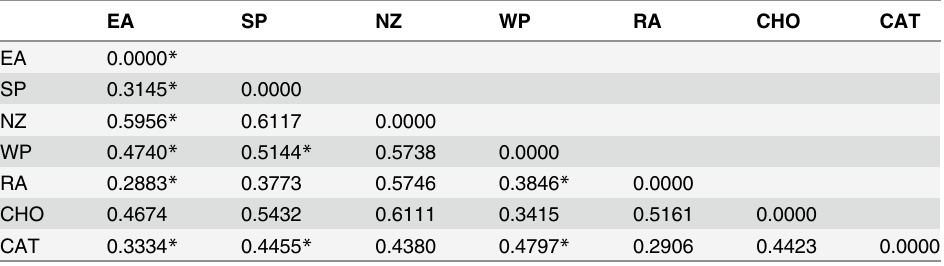
Table 5. Pairwise comparison of Fst between the seven genetic groups.